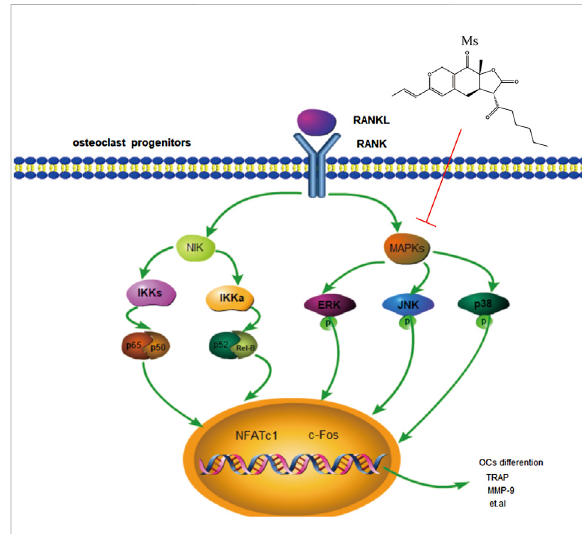
Schematic representation of the mechanism by which Ms inhibits osteoclastogenesis in RAW264.7 cells. RANKL induces MAPKs activation, including activation of JNK, p38 and ERK. Subsequently, the expression of osteoclast-typical genes, MMP-9, CTSK, TRAP, ITG- β 3, OSCAR, and DC-STAMP are upregulated. Our results show that Ms inhibits osteoclastogenesis by inhibiting MAPKs activation. The sign ( ↓ ) means promoting. The sign ( ┴ ) means